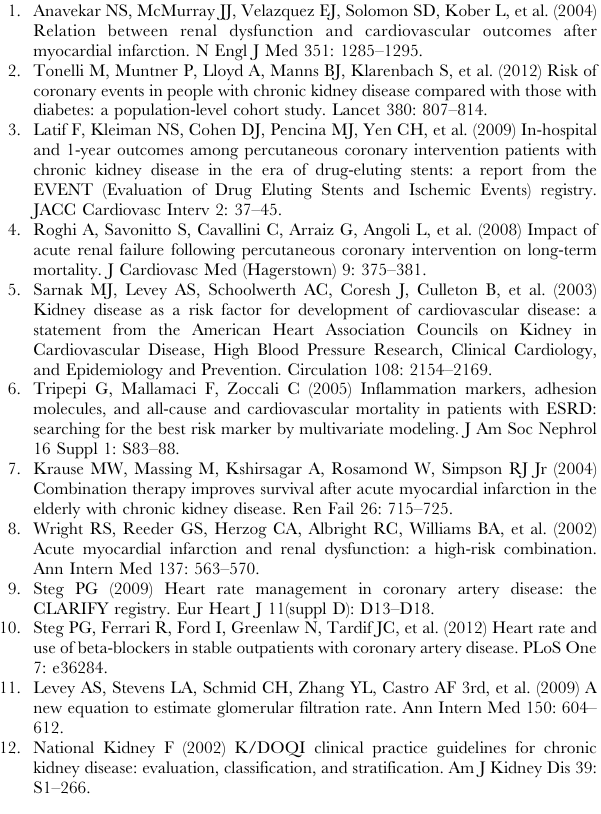
Figure 3. The association of use of (A) angiotensin-converting enzyme inhibitors and (B) angiotensin receptor blocker with chronic kidney disease following adjustment for age, body mass index, systolic blood pressure, diastolic blood pressure, gender,